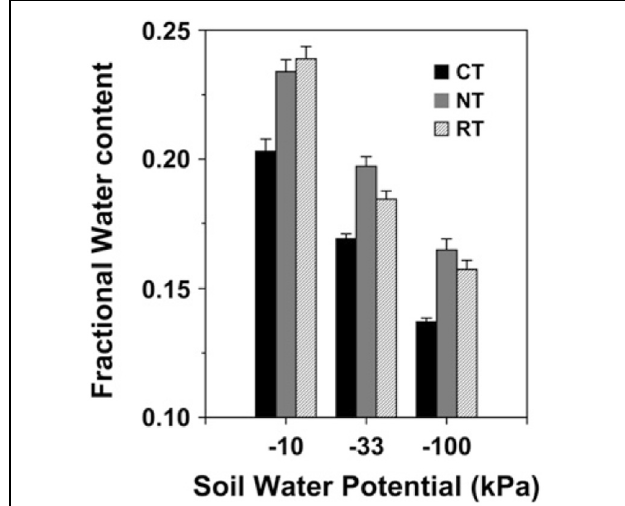
FIGURE 3 | Water holding capacity at three water potentials in the top 2.5 cm of soil after 13 years of conventional tillage (CT), no-tillage (NT), and ridge tillage (RT). Error bars represent ± 1 SE. Reproduced from Zibilske and Bradford